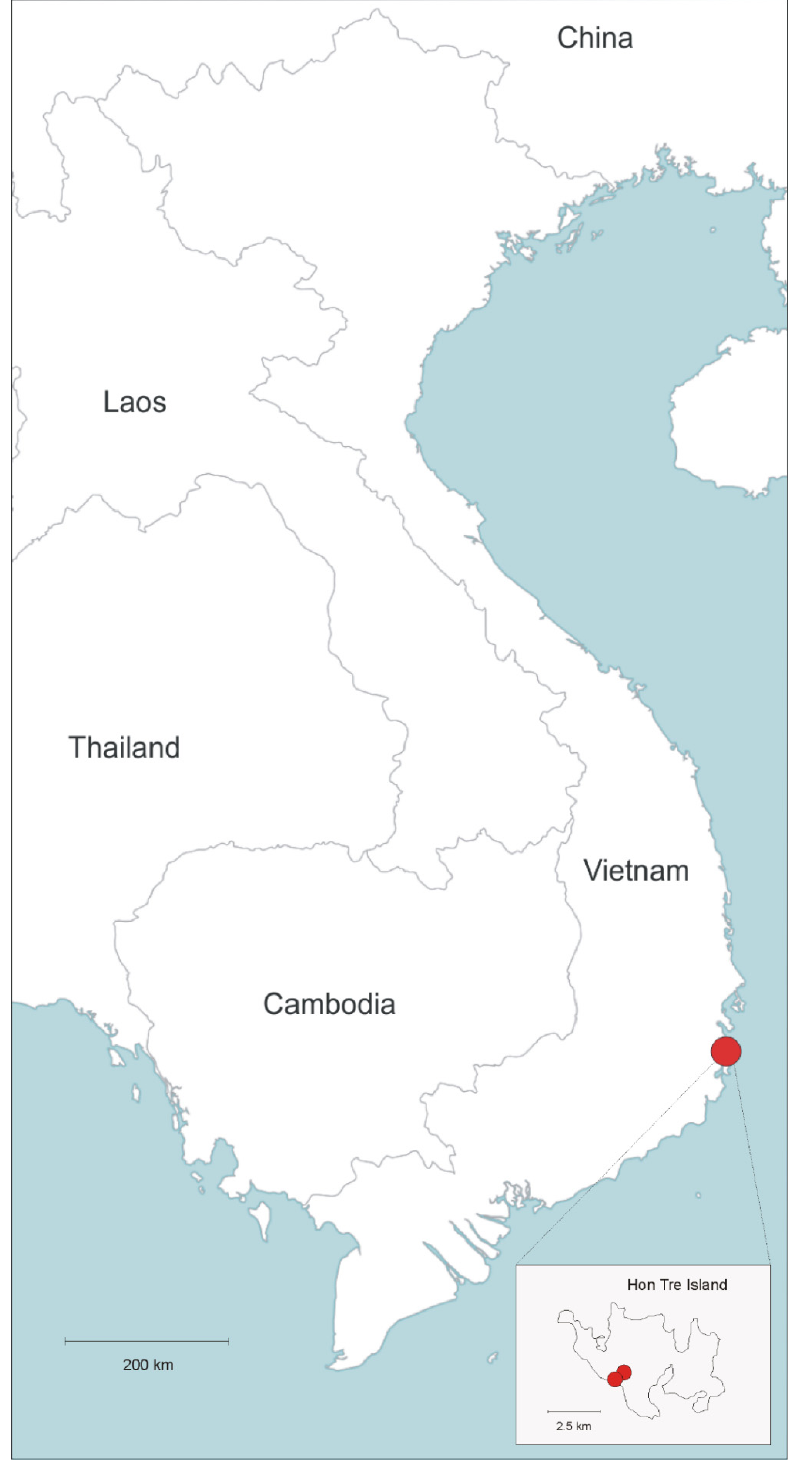
Figure 2. Known distribution of Capparis oxycarpa (red circles).